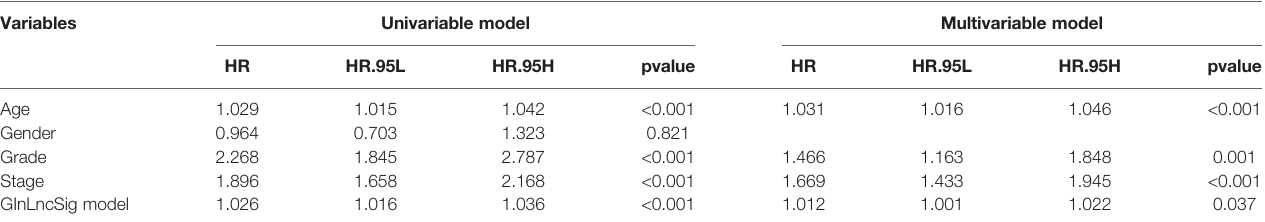
TABLE 2 | Univariate and Multivariate Cox regression analysis of the prognostic model and overall survival in TCGA set.